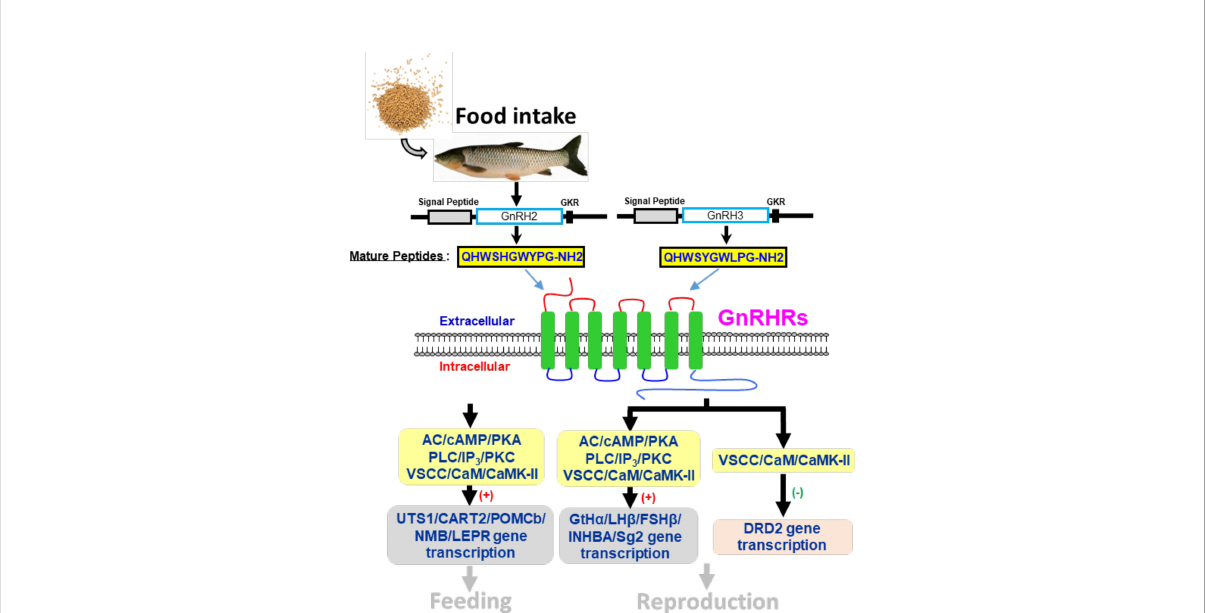
FIGURE 14 Working model of GnRH-mediated feeding and reproduction in grass carp. Two GnRH ligands and four GnRHRs were cloned from grass carp brain, and ligand – receptor selectivity showed that GnRHR3 was a speci fi c receptor for GnRH2 when GnRH3 was preferentially chosen combined with GnRHR1, and GnRHR2 and GnRHR4 might be universal receptors to both GnRHs. Besides, GnRH2 and GnRH3 could both signi fi cantly induce pituitary reproductive hormone gene (GtH a , LH b , FSH b , INHBa, SgII) and feeding hormone gene (POMCb, CART2, UTS1, NMBa, NMBb, and LEPR) mRNA expression mediated by AC/PKA, PLC/IP3/PKC and Ca 2+ /CaM/CaMK-II pathways in vitro . Besides, GnRH2 and GnRH3 could modulate the inhibition of LH by dopamine according to a restrained DRD2 expression via the Ca 2+ /CaM/CaMK-II pathway. Finally, food intake could signi fi cantly induce brain GnRH2 and GnRH3 mRNA